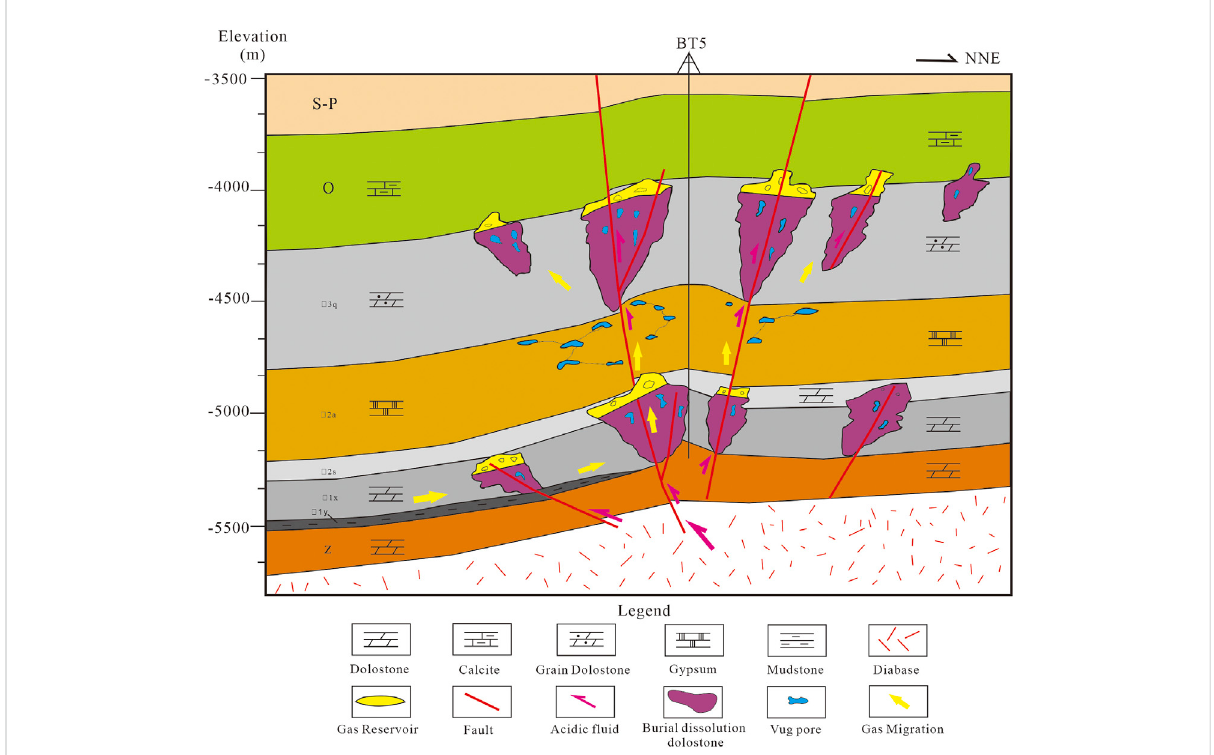
FIGURE 11 Theschematicmodelshowingthatfaultsandhostfaciescontrolthe fl uid fl owintheformationofdissolutionporesintheCambrianreservoirin the Tarim